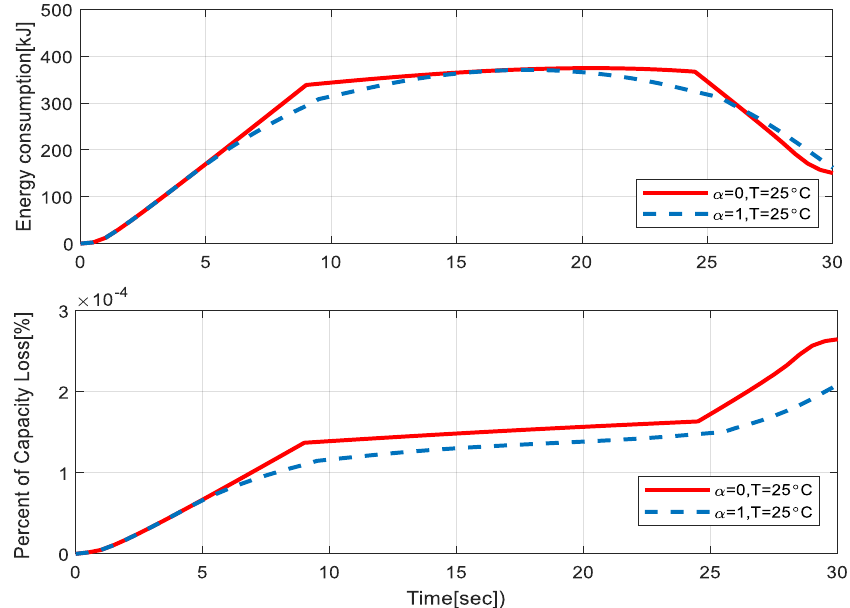
Table 4. Simulation results of different cost functions.